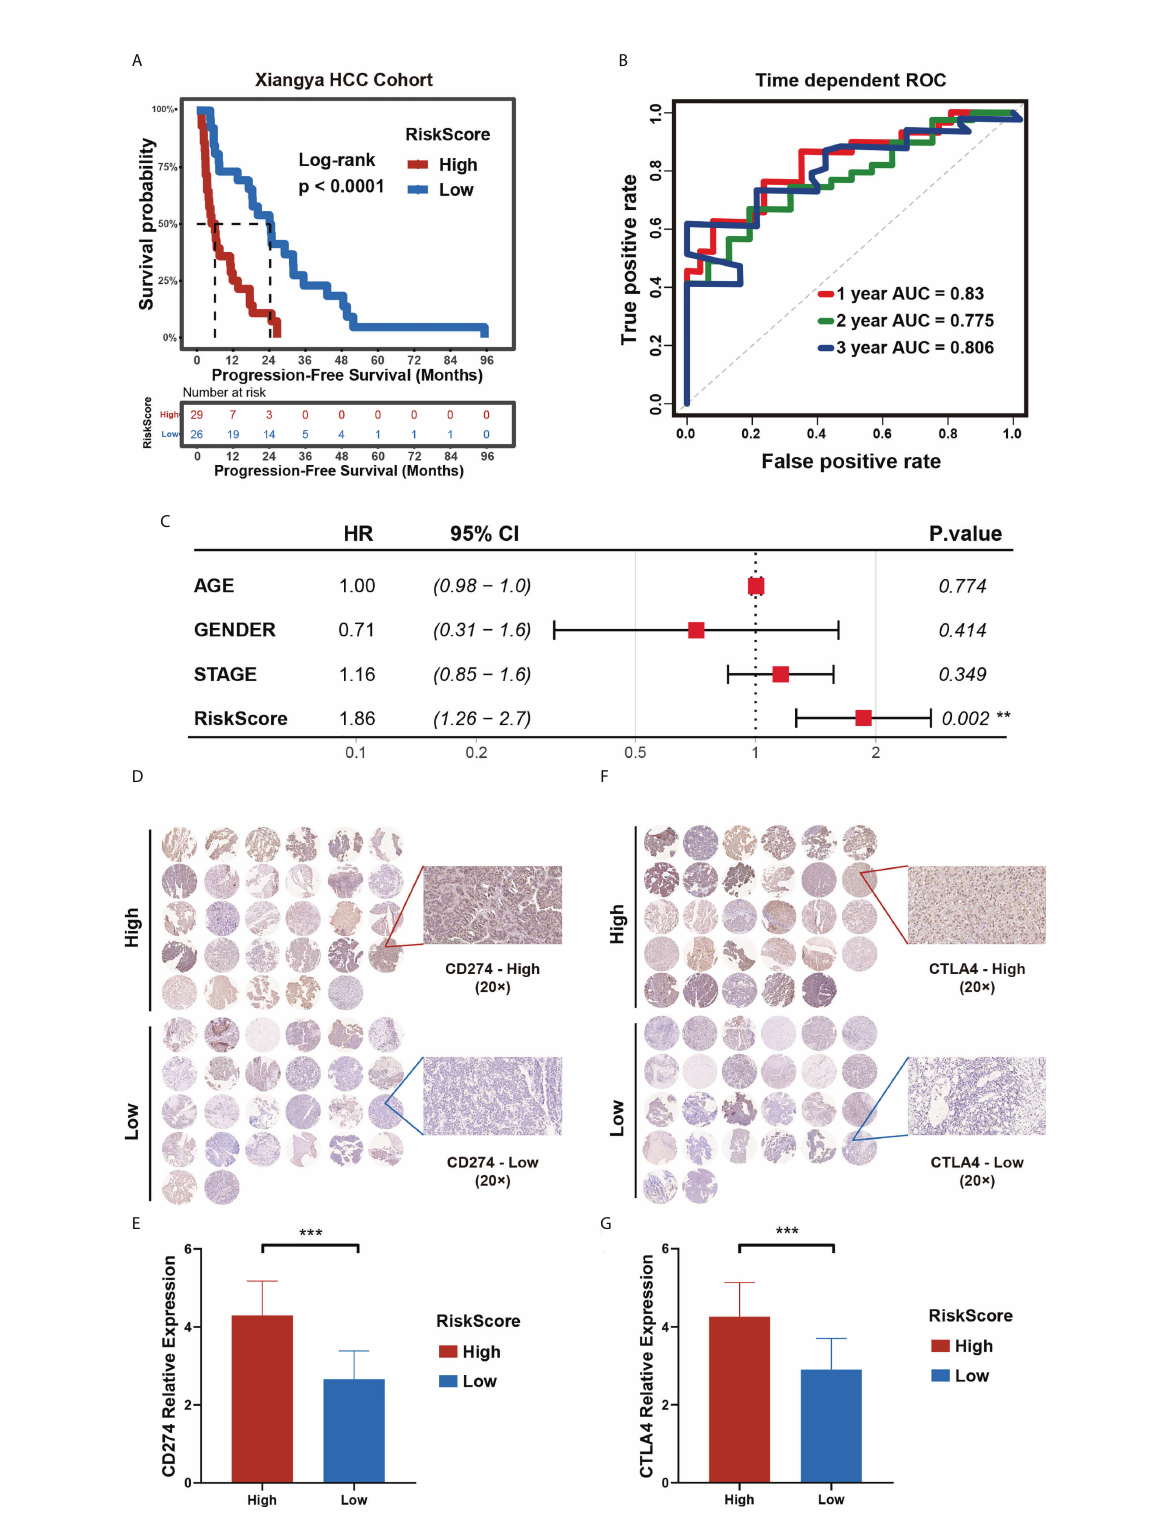
FIGURE 9 Validation of the prognostic risk model in Xiangya HCC cohort. (A) Progression-free survival time in high- and low- m 5 C score groups in Xiangya HCC cohort. (B) Time-dependent ROC curve (H) of the risk score in Xiangya HCC cohort. (C) Multivariate Cox regression analysis of PFS in Xiangya HCC cohort. (D – G) The expression level of CD274 (D, E) and CTLA4 (F, G) in high- and low- m 5 C score groups in the Xiangya HCC cohort. (*p < 0.05, **p < 0.01, ***p < 0.001, ns, no signi fi cant